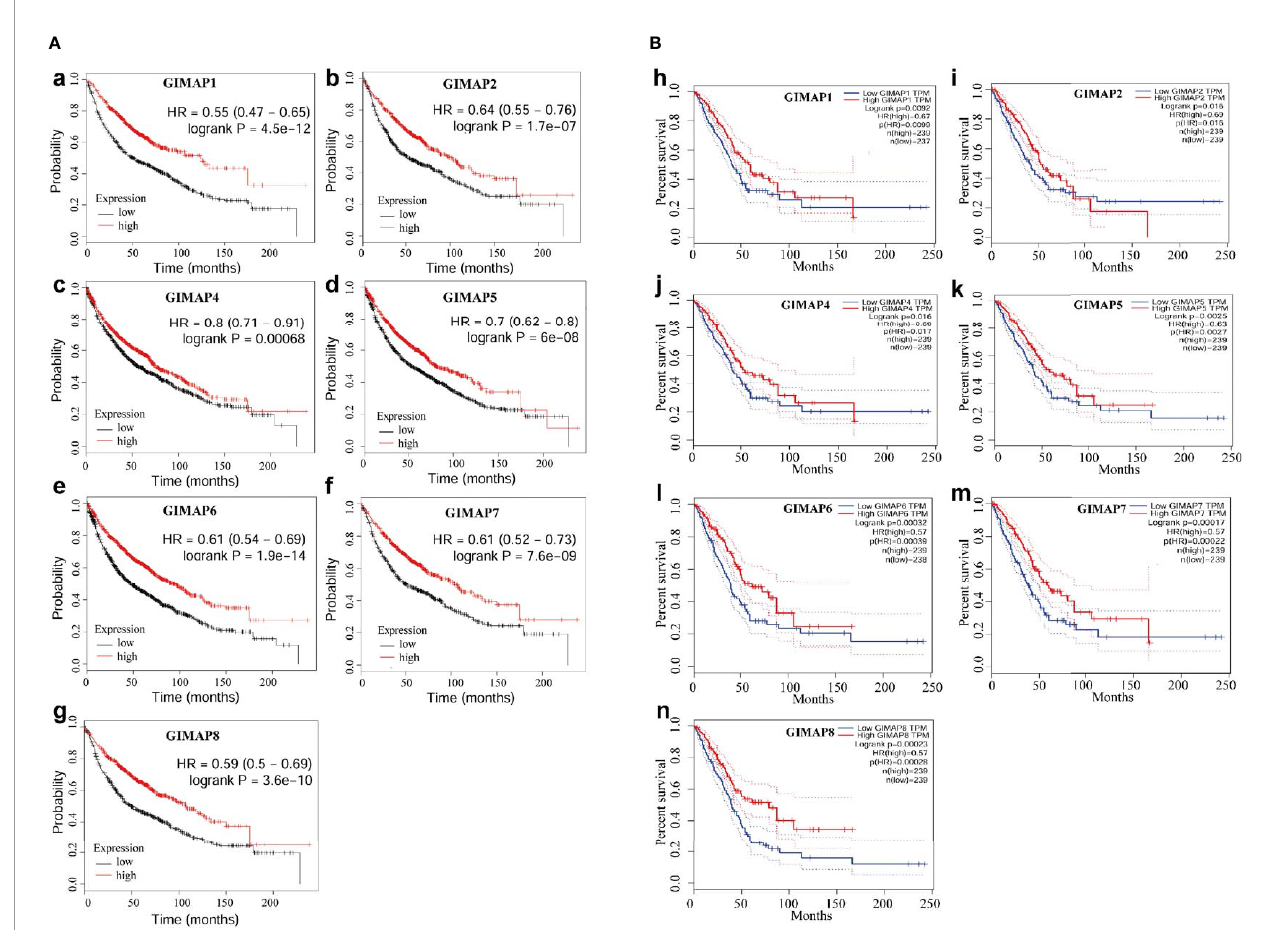
FIGURE 2 | Down-regulation of GIMAP family was associated with poor prognosis of lung cancer. (A) Overall survival analysis of GIMAP family in lung cancer patients from TCGA database (a-g), red lines represent GIMAP higher expression, the higher survival probability and black lines represent the lower GIMAP expression, the lower the survival probability. (B) Prognostic value of GIMAP family in lung cancer patients from GEO database. Log-rank test was performed to evaluate the survival differences between the two curves (h-n), red lines represent GIMAP higher expression, the higher survival and blue lines represent the lower GIMAP expression, the lower the survival